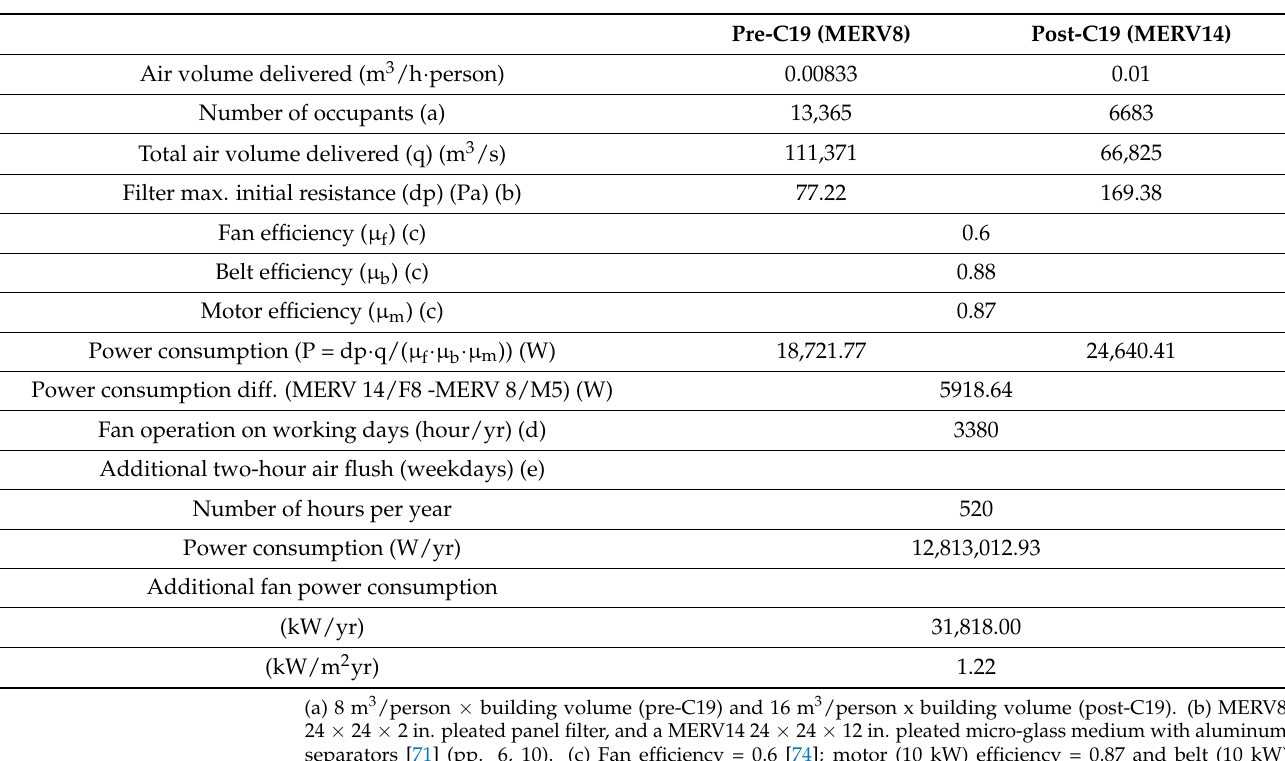
Table 7. Fan power energy